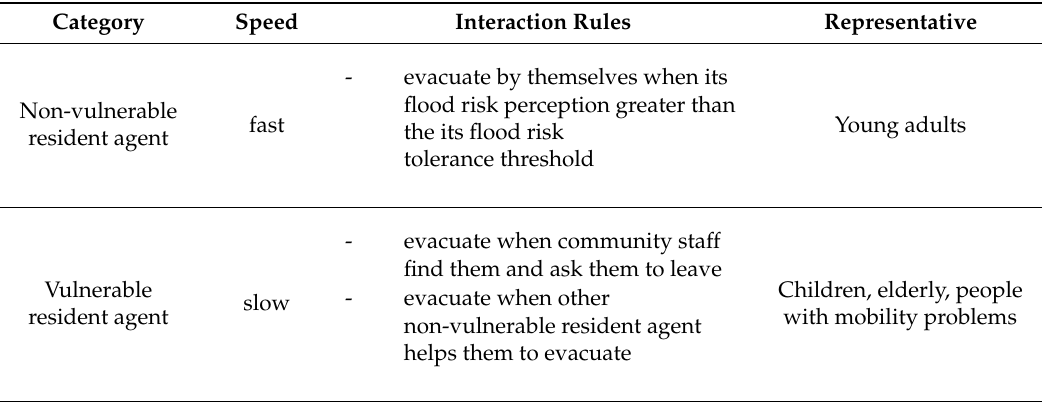
Table 2. Description of di ff erent categories of resident